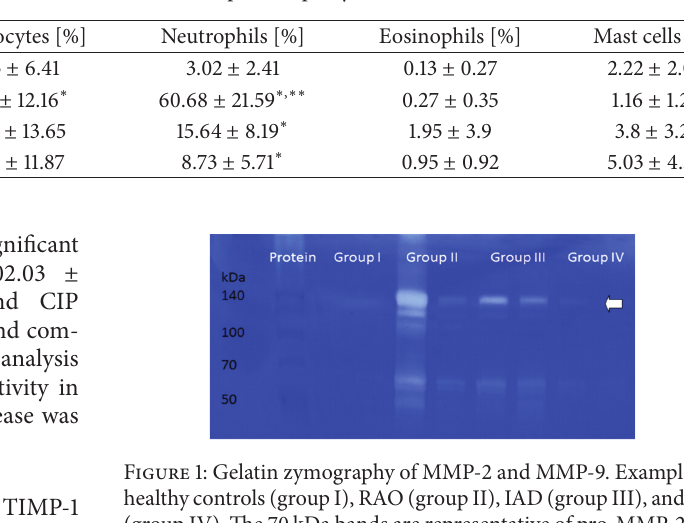
Table 5: For BAL cytology, the results of cell percentages are expressed as mean ± SD. ∗ shows significant differences to controls at 𝑝 < 0.05 , ∗∗ significant increase in RAO compared to IAD and CIP, and ∗ ∗ ∗ significant decrease in RAO compared to IAD and CIP. RAO: recurrent airway obstruction, IAD: inflammatory airway disease, and CIP: chronic interstitial pneumopathy.